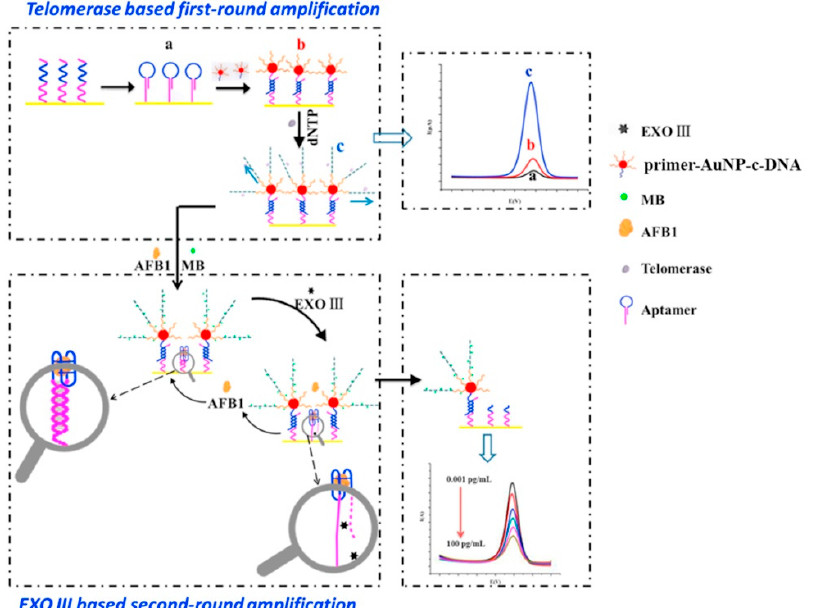
Figure 7. The schematic process of signal-amplified electrochemical aptasensor for AFB1 detection (( a ) formation of stem-loop structure of the immobilized probe; ( b ) immobilization of TS-primer-AuNP-cDNA onto the sensing interface; and ( c ) telomerase-based first-round amplification). Reproduced from [51]. Copyright 2016 Elsevier.